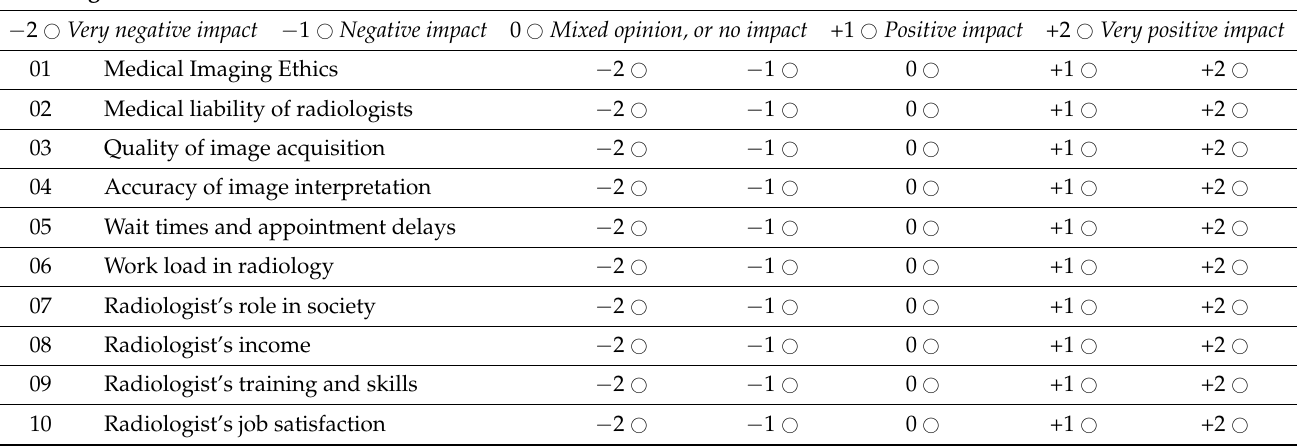
Table A3. Attitudes regarding Artificial Intelligence impact on the radiologist profession.